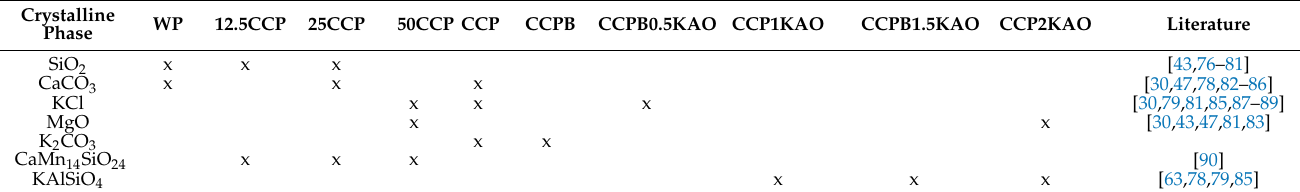
Table 4. Crystalline phases identified in the grate ash (GA) samples (for experimental list see Table 2). Crystalline